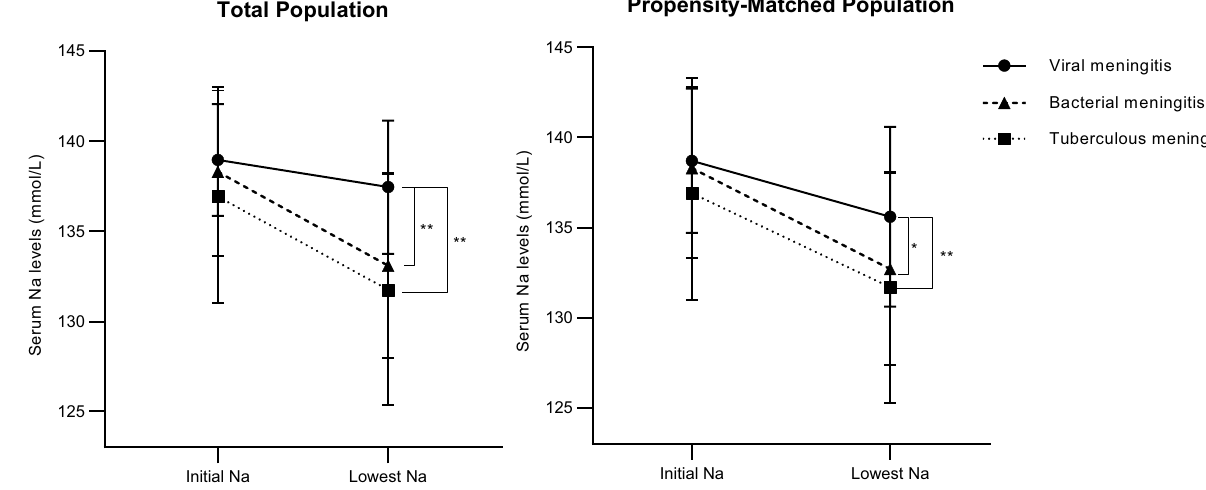
Figure 1. Changes in serum sodium level in VM, BM, and TBM groups. P values for the grou p × time interactions are demonstrated. * p < 0.05, ** p < 0.01.